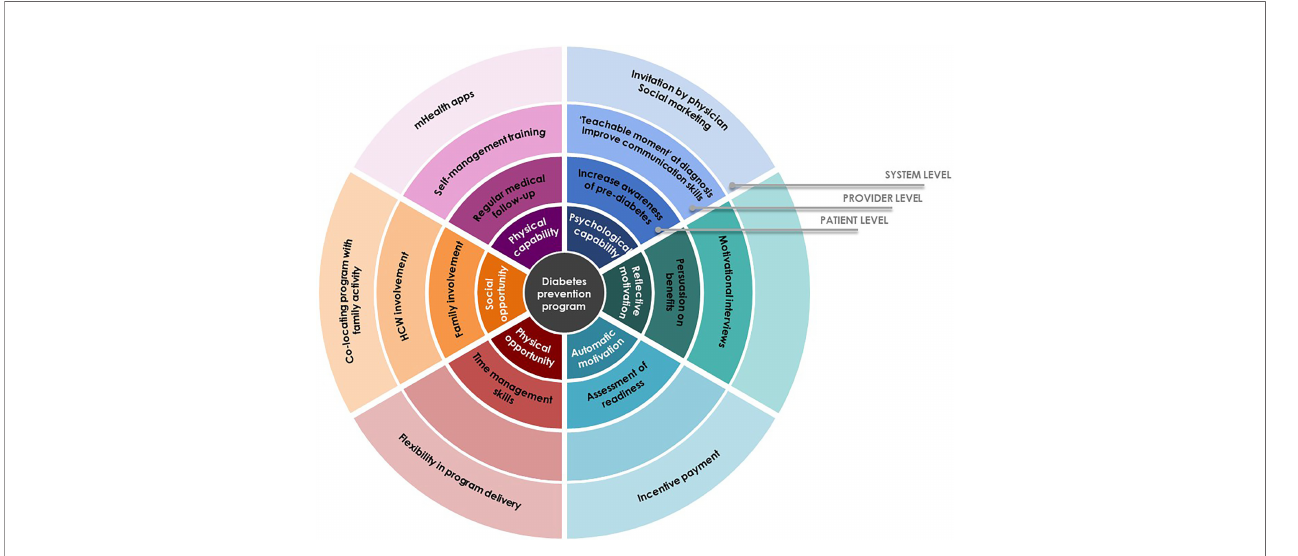
FIGURE 1 | Potential intervention